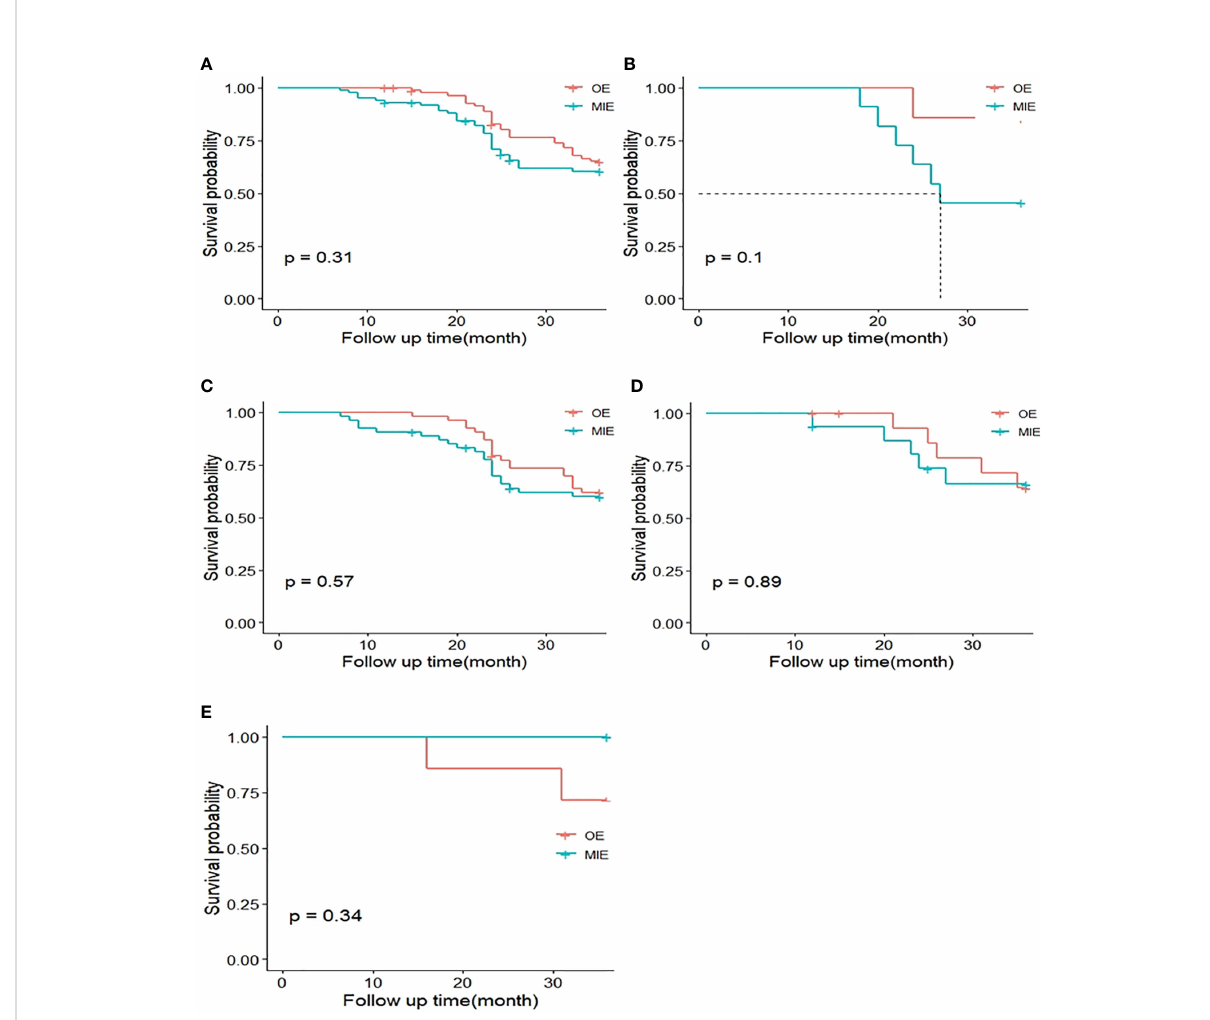
FIGURE 5 Kaplan – Meier curves of 3-year overall survival (OS) between both groups. (A) OS curves of the MIE and OE groups after matching. (B) OS curves of patients with %FEV1 50% – 60%. (C) OS curves of patients with %FEV1 60% – 70%. (D) OS curves of patients with %FEV1 70% – 80%. (E) OS curves of patients with %FEV1